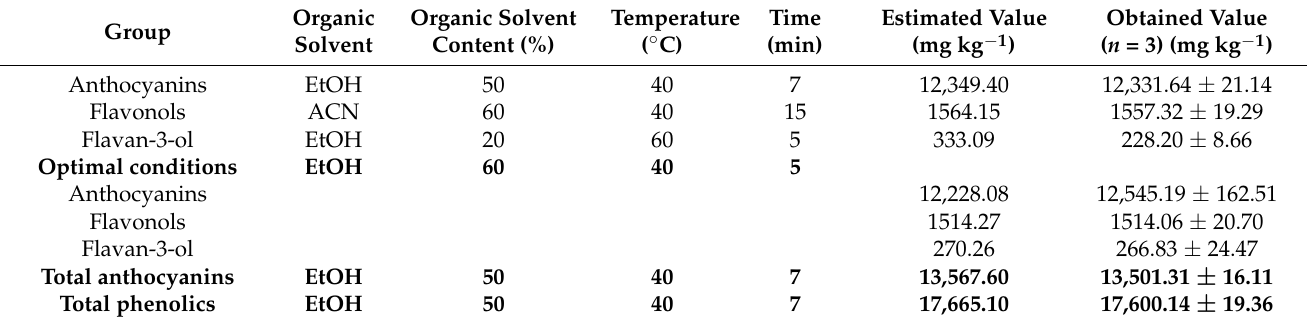
Table 6. Optimal MAE extraction conditions with their predicted and experimentally obtained values for individual groups of